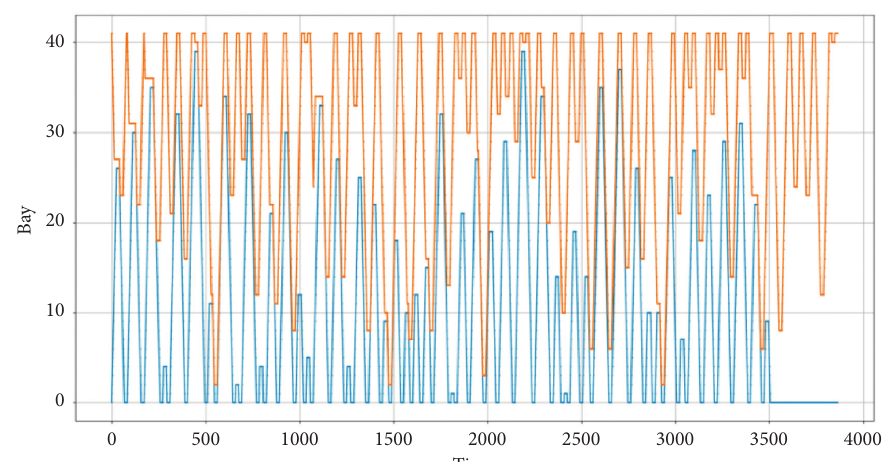
Figure 9: Algorithm convergence graph.